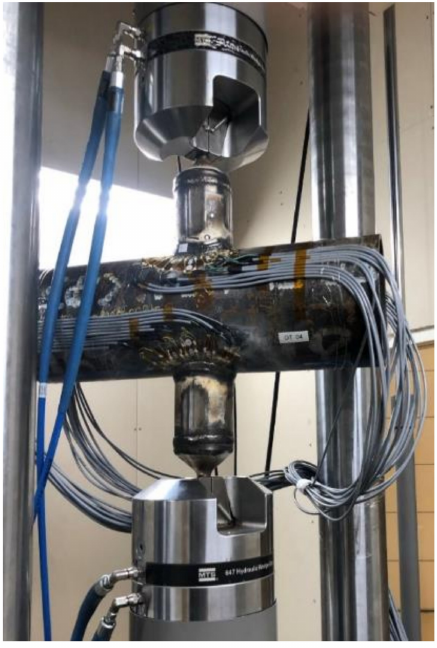
Figure 6. Test specimens